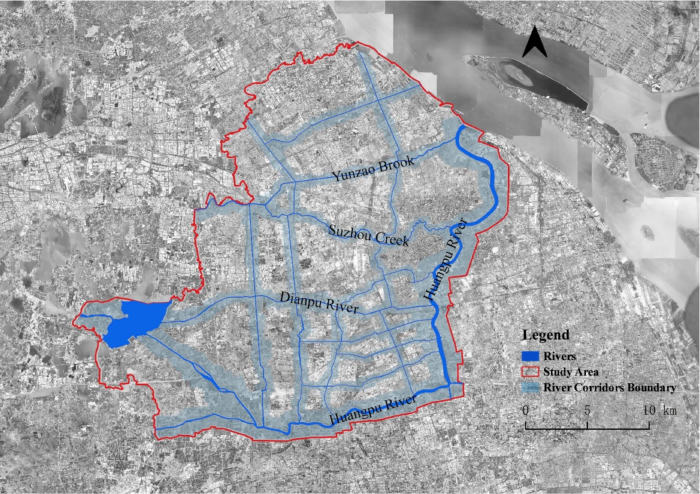
Figure 1. Locations of the backbone river corridors and their river buffer areas in the study